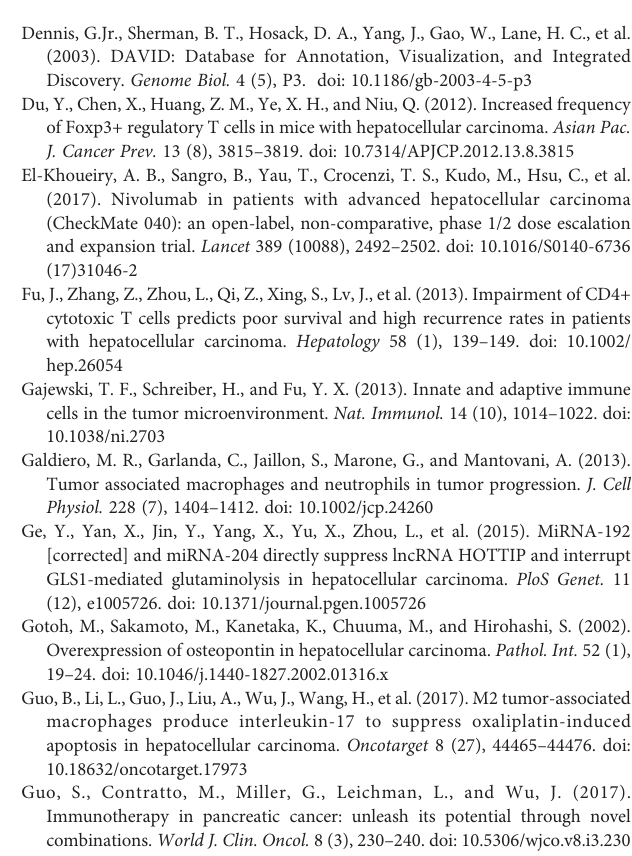
SUPPLEMENTARY FIGURE S1 | Construction of a validation model of GSE76427. Heatmap (A) of survival-associated IRGs in the prognostic model. (B) Rank of risk score and distribution of groups. (C) Survival status of patients in different groups. SUPPLEMENTARY FIGURE S2 | The prognosis of validation